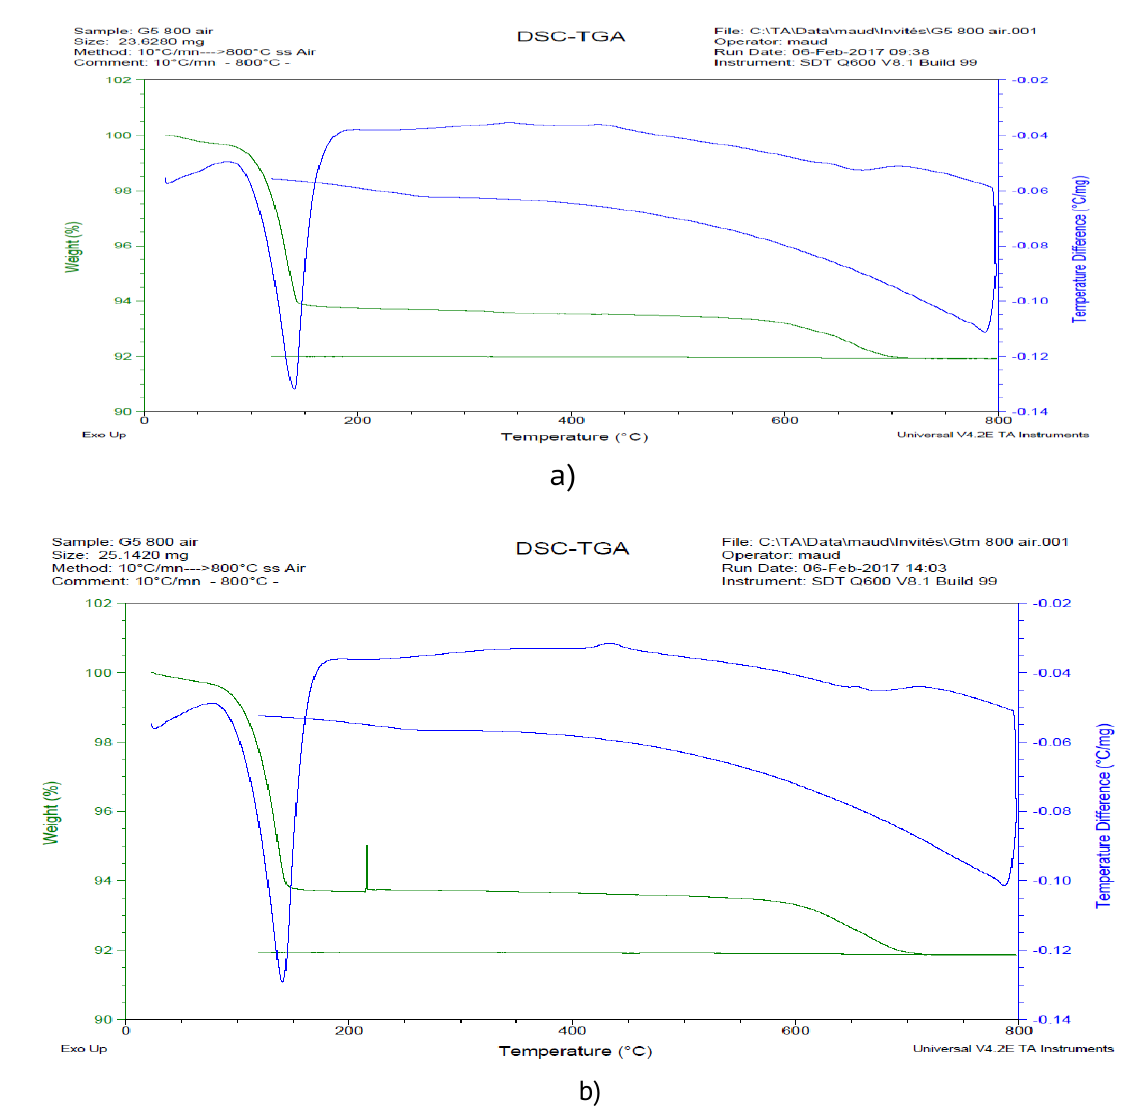
Figure 2. Differential thermal analysis curves for building gypsum: a – unground; b – finely